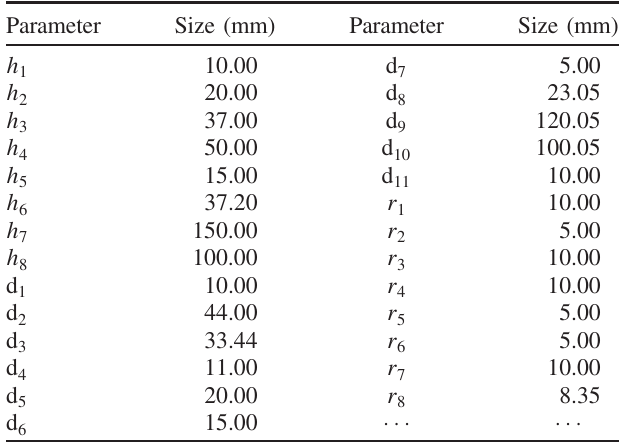
TABLE I. The values of the geometrical parameters for the different lengths shown in Fig. 7.